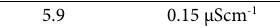
Fig. 1.Schematic diagram of the experimental setup.